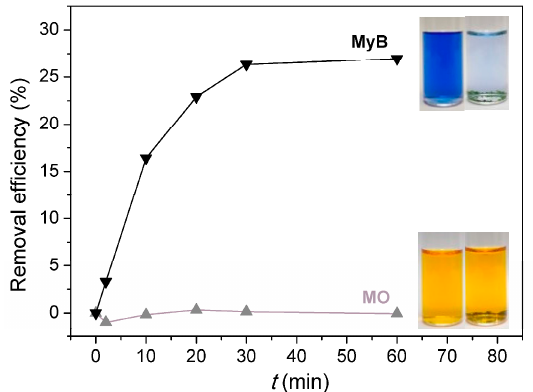
Figure 3. Dye removal efficiencies of 1 in a single dye solution of MyB and methyl orange (MO) in water with time. Inset photos: The color of the aqueous solutions of MyB (upper) and MO (lower) before (left) and after (right) adsorption by adsorbents for 60 min.